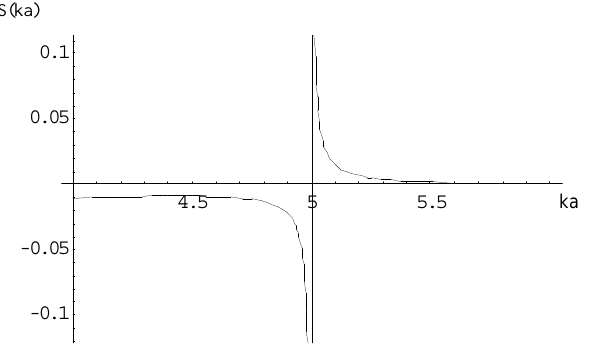
Fig. 2. The factor S(ka) plotted as a function of ka for L ∼ 6 R E , a ∼ 30 R E with | B z | ∼ 25 nT and δ i ∼ 10 4 km. We see from the figure that for short scale length ka ≥ 5 this function is